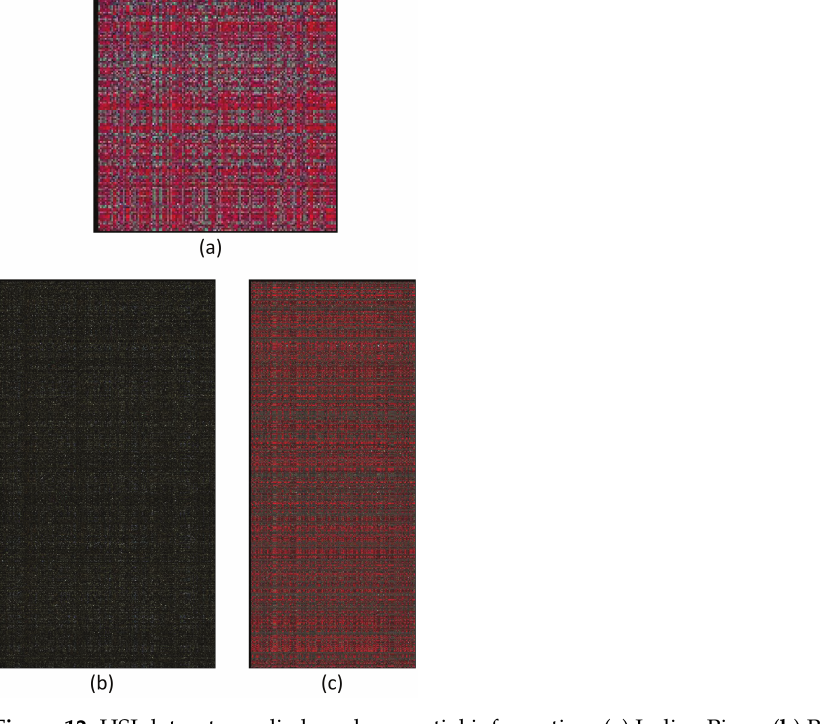
Figure 12. HSI datasets applied random spatial information: ( a ) Indian Pines, ( b ) Pavia University, ( c )